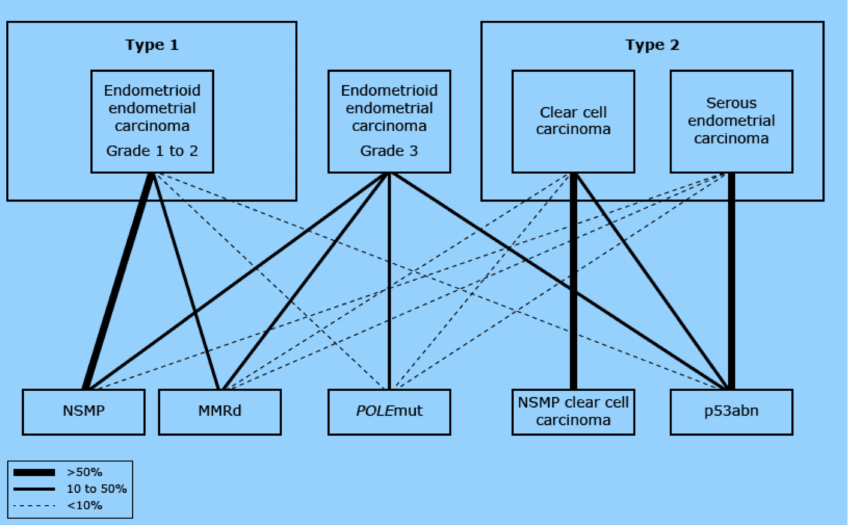
Figure 1. Relationship between the traditional histologic classification and the molecular classification. Each traditional histologic diagnosis is connected to the representing molecular subgroup. The thicker the connecting line, the stronger the relationship. The figure demonstrates that each molecular subgroup can be detected in each histologic subgroup. Yet, the NSMP is mainly reflected by grade 1 and 2 EEC (left in the figure), whereas the p53abn cancers are mainly reflected by patients with SC (right in the figure). EEC: endometrioid endometrial cancer; CCC: clear cell carcinoma; SC: serous cancer; NSMP: nonspecific molecular profile; MMRd: mismatch repair deficient; POLE: POLE ultramutated; p53abn: copy number high/TP53 mutated. (Modified from [9] UpToDate Endometrial cancer: Pathology and classification by Huvila J, MD, PhD, McAlpine JN, MD, FACOG,